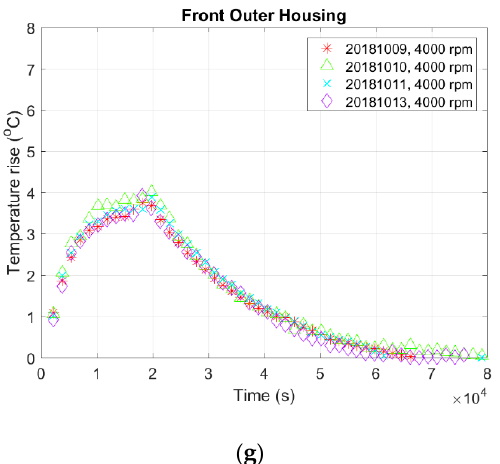
Figure 13. The temperature variations of seven spindle’s characteristic points at the same rotational speeds to that of Figure 8b but measured on different dates: ( a ) rear bearing A; ( b ) rear bearing B; ( c ) front bearing C; ( d ) front bearing D; ( e ) inner housing mid; ( f ) rear outer housing; ( g ) front outer housing.